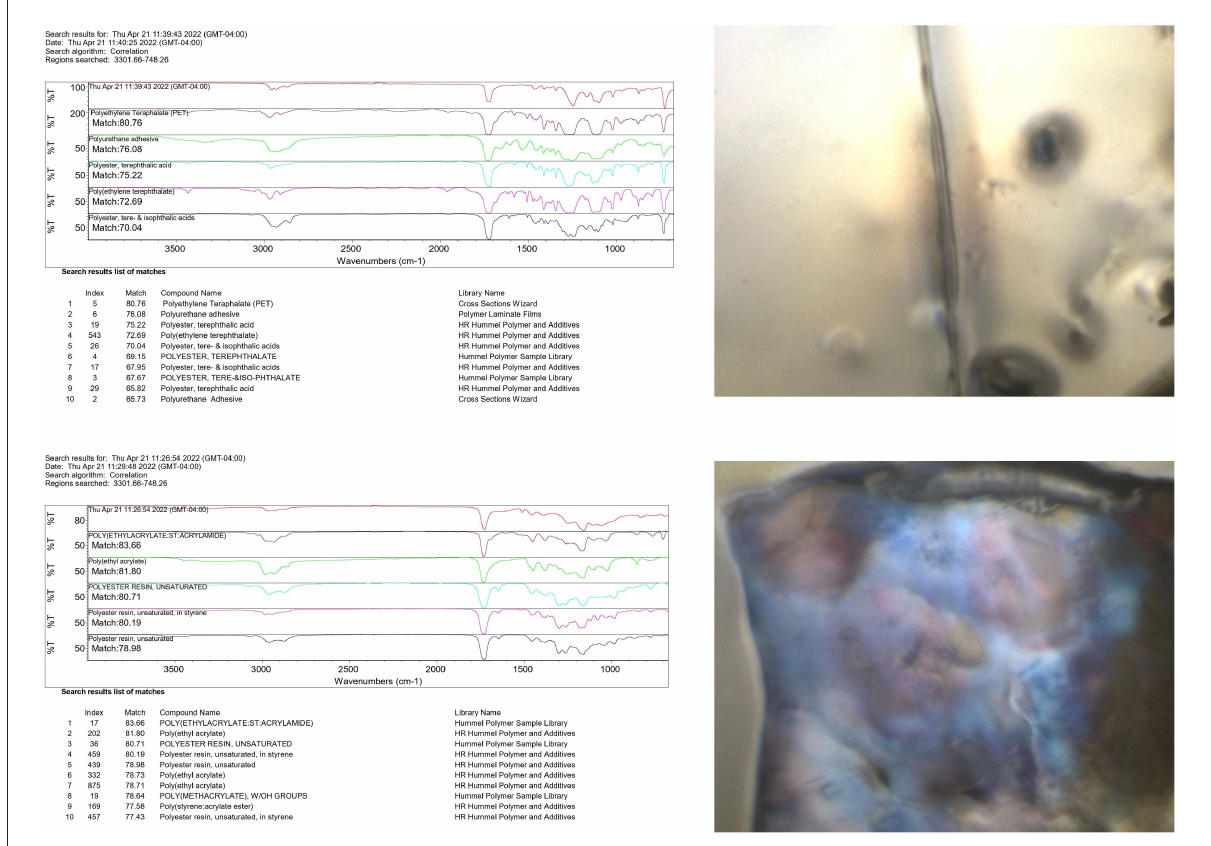
FIGURE7 Micro-FTIR analysis of two suspected plastics from LeBreton